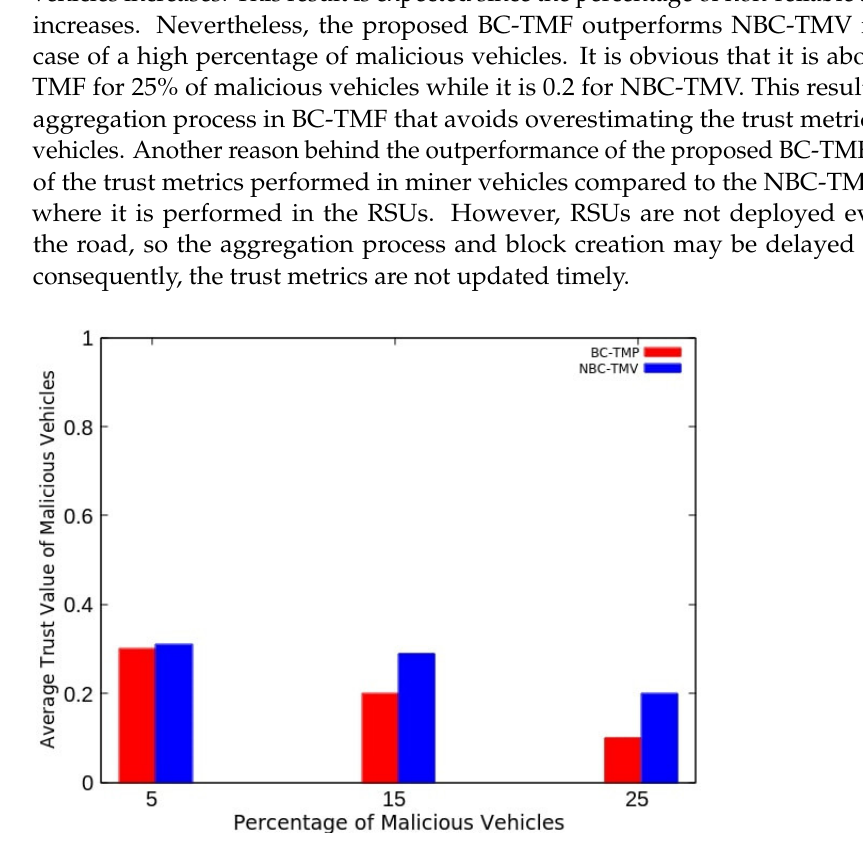
Figure 9. The variance of the trust metrics for non-malicious vehicles vs. addblockTimer (s) . Figure 9, portrays the variance of the global trust metric for the non-malicious vehi- cles as a function of addBlockTimer for different speed and sendTransTimer values. It is obvious from Figure 9 that the variance does not exceed 0.01 in all scenarios, which confirms the consistency of the obtained trust metrics presented in Figures 4 and 5 shown above. Similarly, Figure 10 portrays the variance of the global trust metric of malicious ve- hicles as a function of PM, it is computed as in Equation (4) below: